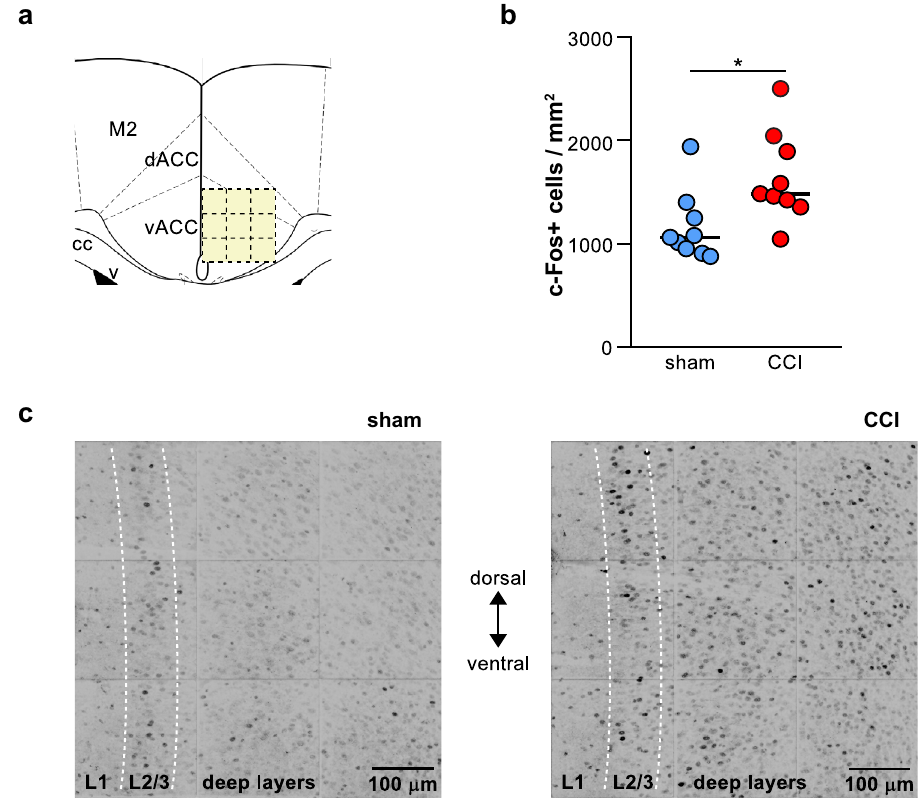
Figure 2. Enhanced number of c-Fos expressing cells in deep layers of the ventral ACC (vACC) in CCI- induced neuropathic pain. (a) Schematic diagram showing the grid of 9 squares (200 × 200 um each) covering the vACC used as region of interest for c-Fos expression analysis. M2, secondary motor cortex; dACC, dorsal ACC; cc: corpus callosum; v: ventricle. (b) The number of c-Fos immunoreactive neurons in deep layers of vACC was higher in CCI compared to sham mice (CCI n = 9; Sham n = 9; * p < 0.05, Mann Whitney test). (c) Representative confocal fluorescence microscopy images showing c-Fos immunoreactive neurons in sections of the CCA. Adjacent images were aligned to reconstruct the entire region of